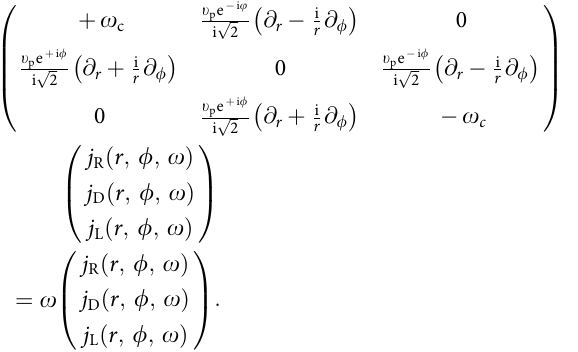
p ffiffiffiffiffiffiffiffiffiffiffiffiffiffiffiffi o 2 (cid:2) o 2 c Þ are the n -th order Bessel and Neumann functions, and